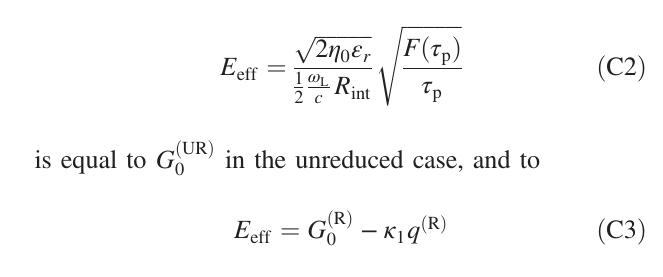
FIG. 6. For the parameters λ (a) Wake ’ s weight functions W s (blue) for the first 60 modes and their corresponding angular frequencies ω s (red) for R (b) Group velocity of the envisaged structure as a function of the internal